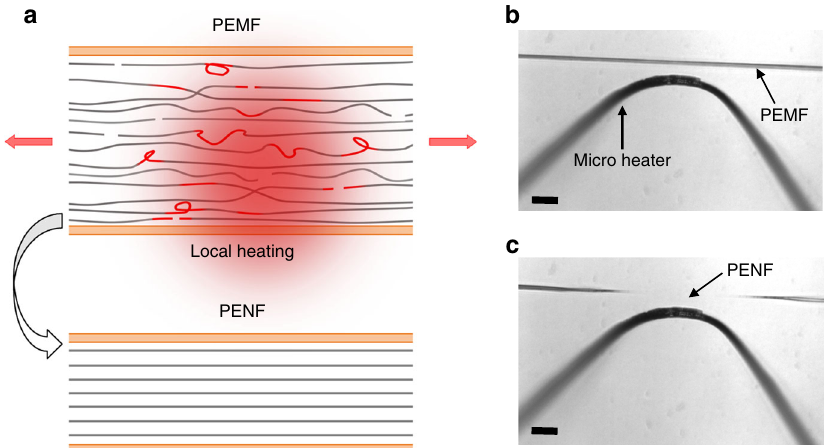
Fig. 1 Fabrication of a PE nano fi ber (PENF). a Idealized schematics of localized drawing with a microheater to fabricate PENF from a PE micro fi ber (PEMF). Arrows indicate drawing directions whereas red lines highlight the defects in PEMF. b-c Optical micrograph before and after localized drawing (in c , nano fi ber not resolved optically). Scale bars, 20 µ